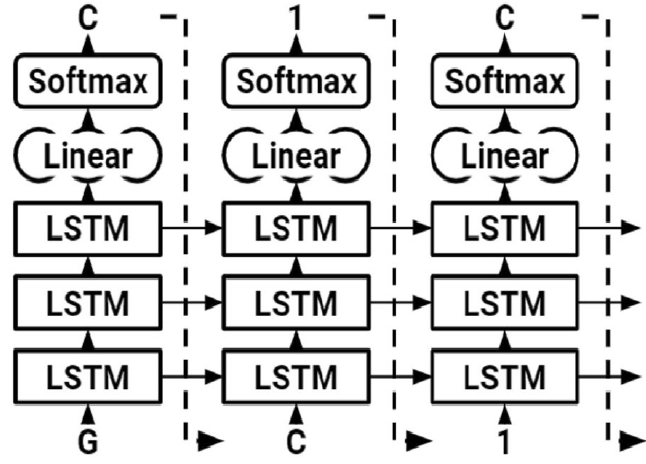
Figure 8. LSTM used to generate SMILE of modified gedunin.